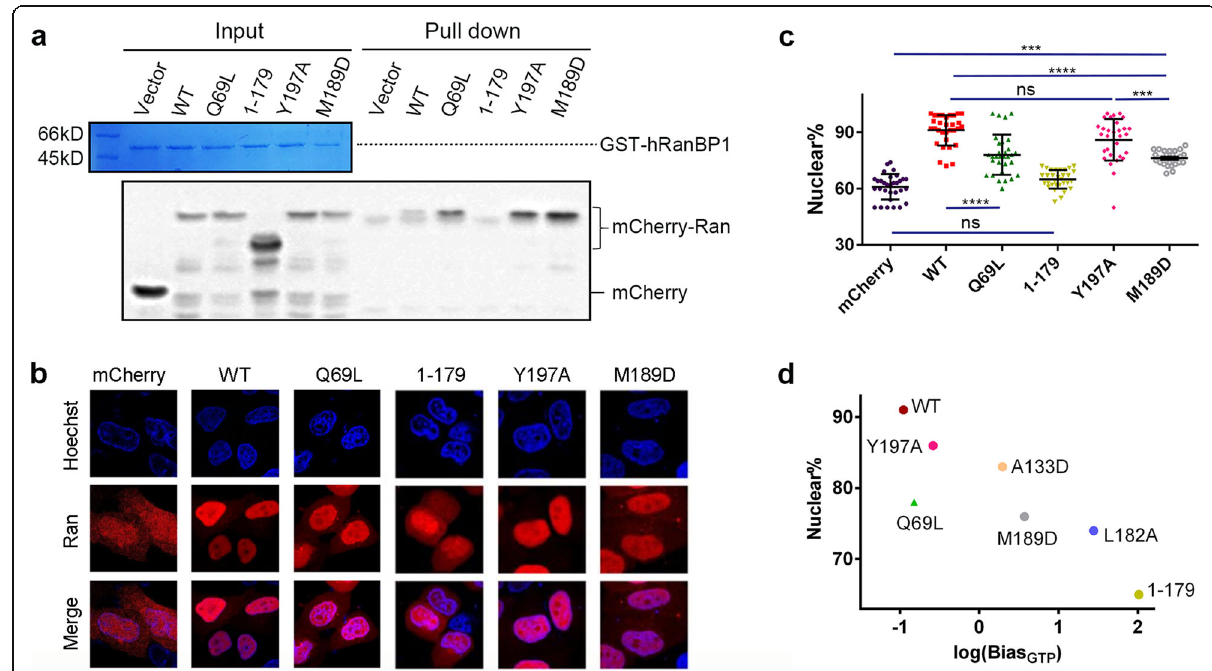
Fig. 3 Greater GTP-loading level and cytoplasmic re-localization of Ran C-dis mutants in human cells. a GST-hRanBP1 pull-down of mCherry-Ran constructs transiently expressed in 293 T cells. Ran proteins were stained with mCherry antibody. Ran 1 – 179 does not bind to RanBP1 because of lacking the C-terminus. The weak bands in Vector and 1 – 179 samples represent non-specific staining. b Intracellular localization of mCherry- tagged Ran proteins in transfected HeLa cells. c Quantification and statistical analysis of localization in panel ( b ). Percentage of nuclear Ran for each cell is calculated as Ran nuclear intensity divided by total cellular intensity. Middle horizontal lines represent the mean, and vertical lines represent the standard deviation of each set of data containing measurements from at least 30 cells. Levels of significance are analyzed by One- way ANOVA. **** p < 0.0001, *** p < 0.001, ** p < 0.01, * p < 0.05. d The negative correlation between the log scale of Bias GTP and the percentage of nuclear Ran. The Pearson correlation coefficient for the seven proteins is −